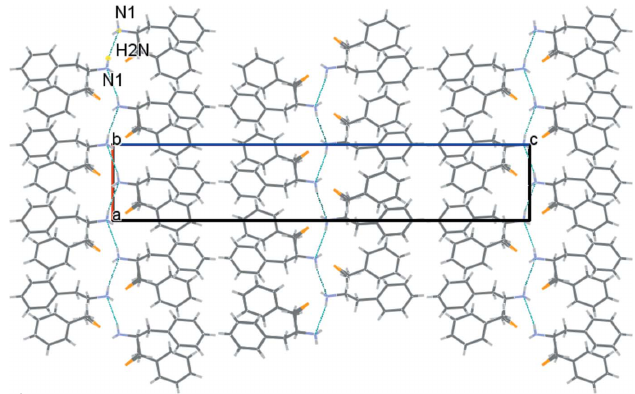
Figure 2 The packing of the title compound viewed along [010] showing the formation of [100] hydrogen-bonded